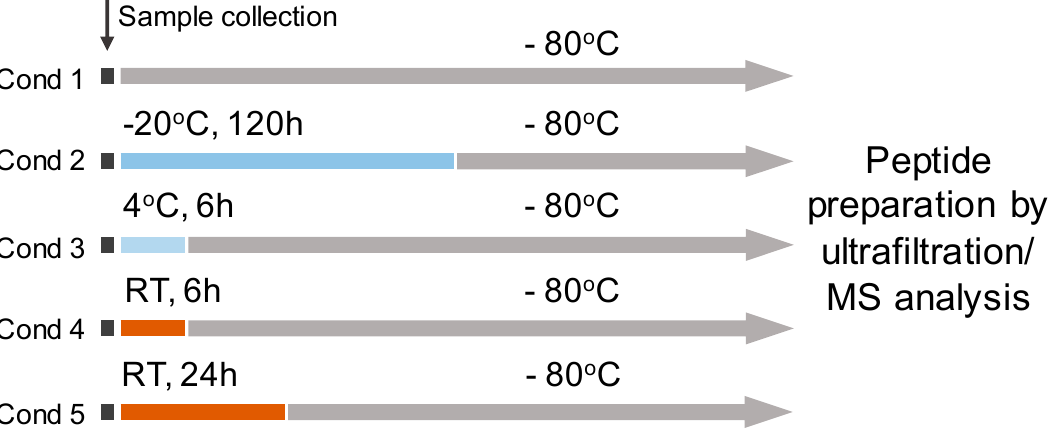
Figure 1. Study design for comparison of the stability of the human breast milk peptidome in different storage conditions.